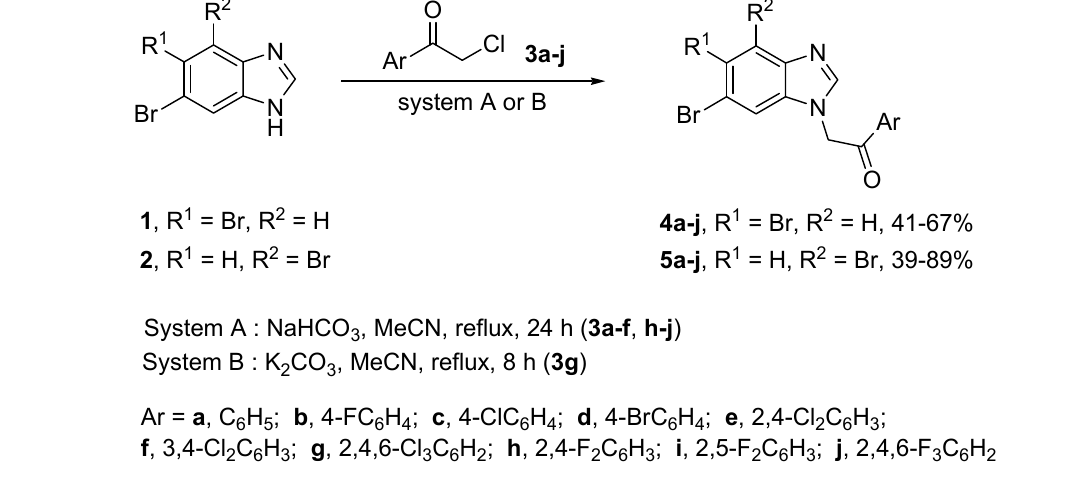
Scheme 2. Synthesis of N-phenacyldibromobenzimidazoles 4 and 5 in the optimized conditions. Table 3. Synthesis of compounds 4 and 5 in NaHCO 3 –MeCN system.